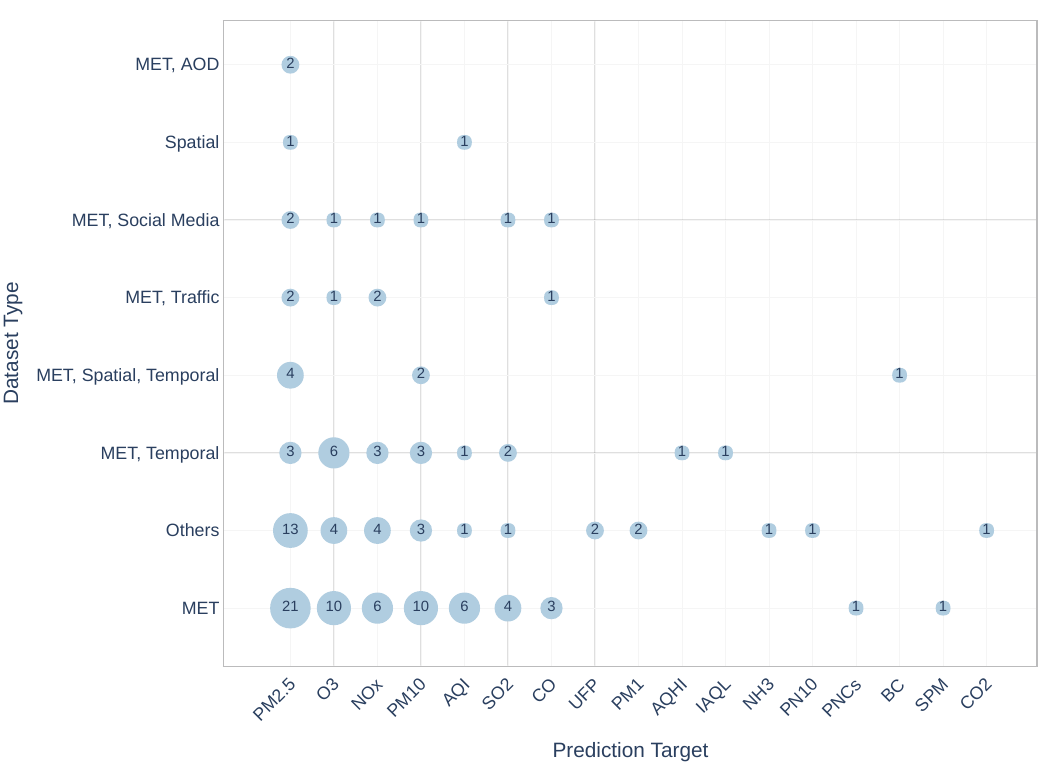
Figure 5. The number of publications of dataset combinations in terms of prediction target. Data Rate : is the timespan during which the sensors provided data. Figure 6 shows the distribution of dataset combinations in terms of data rate. Overall, biweekly, daily,